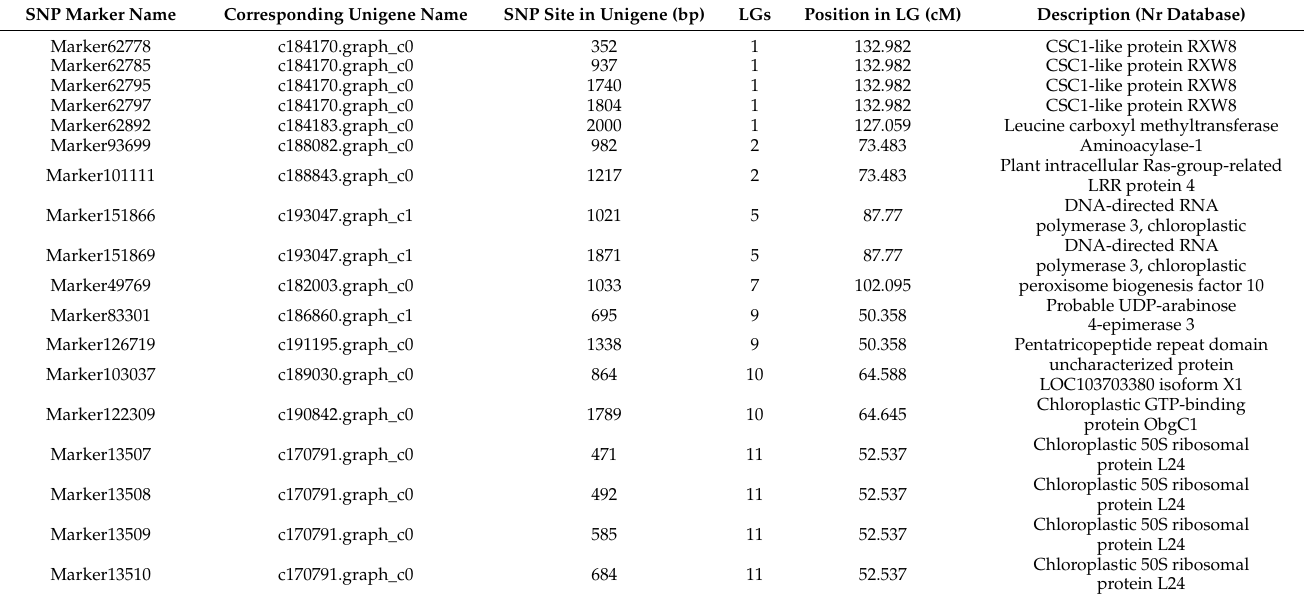
Table 7. Information on the candidate SNP markers and their corresponding unigenes with GO